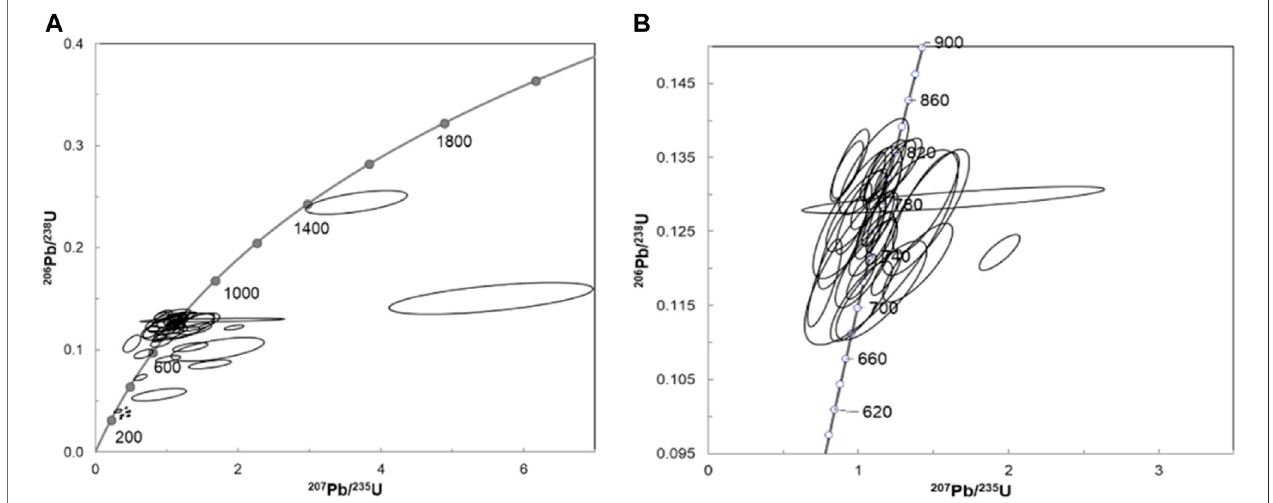
FIGURE 6 | Zircon U-Pb concordia diagram for paragneisses (A) ; zircon U-Pb concordant ages in the range of 705 – 811 Ma (B) .